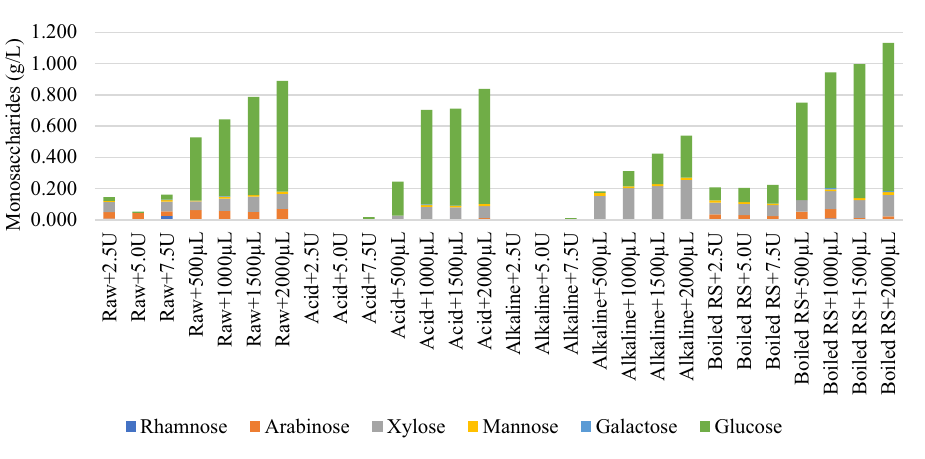
Figure 8. Detection of Monosaccharides production in liquid